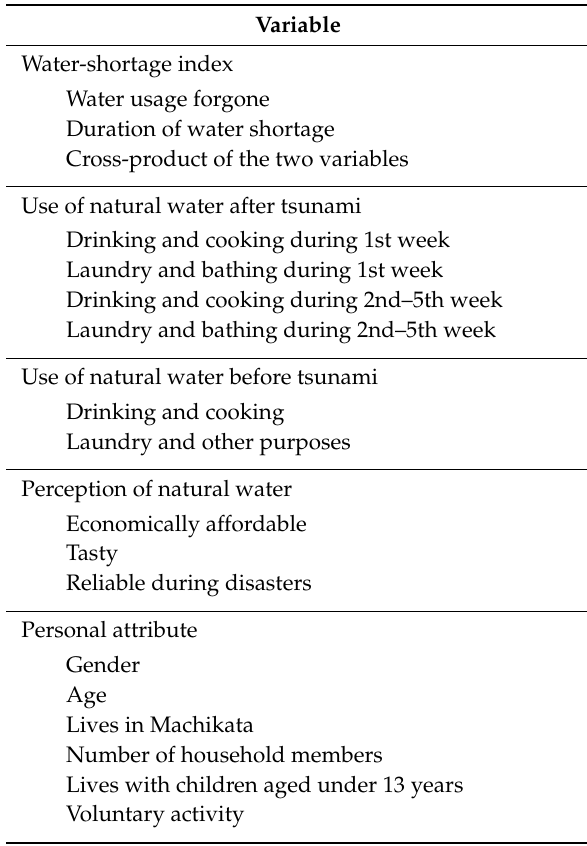
Table 1. Explanatory